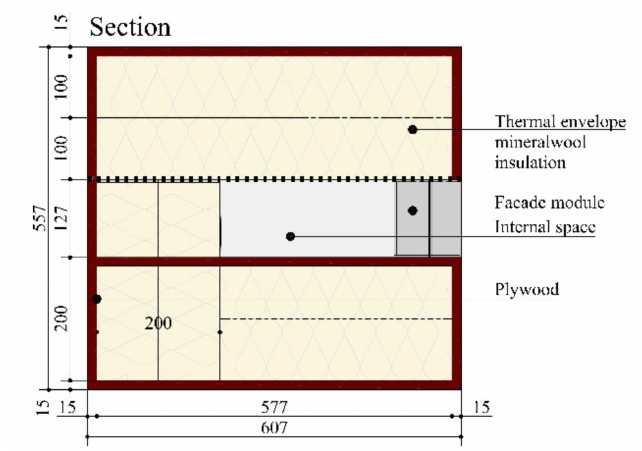
Figure 4. Small-scale PASLINK type test